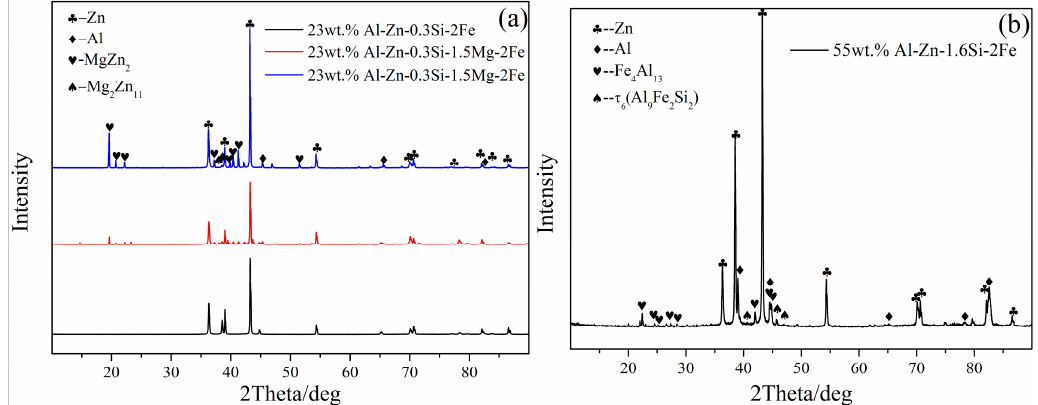
Figure 16. X-ray diffraction result of the bottom dros: ( a ) 23AZS– x Mg–2Fe, ( b ) 55AZS–2Fe.